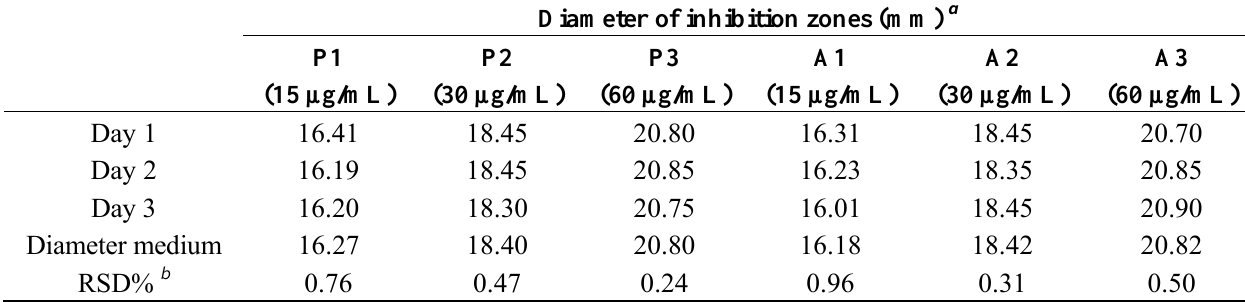
Table 1. Diameters of inhibition zones obtained in the microbiological assay for evaluation the linearity of ceftriaxone sodium in pharmaceutical products-agar diffusion